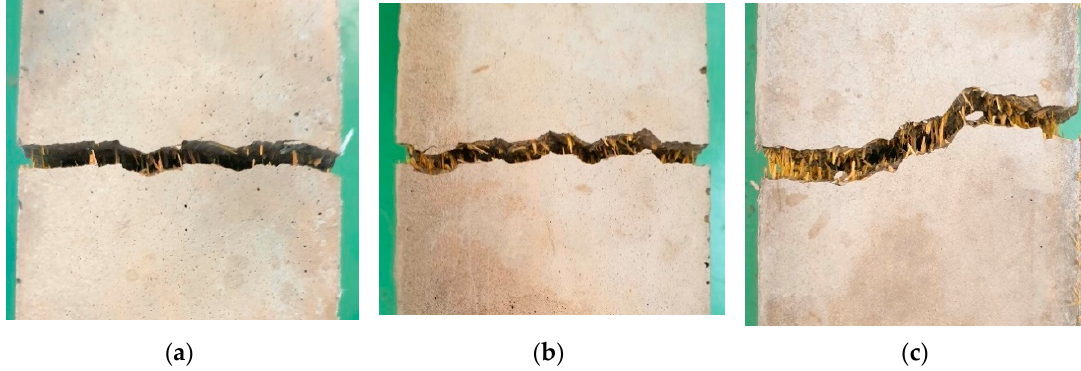
Figure 6. Photographs of test samples after bending tests involving 500 μ m fibers. Fiber content: ( a ) 4 V%, ( b ) 6 V% and ( c ) 8 V%.